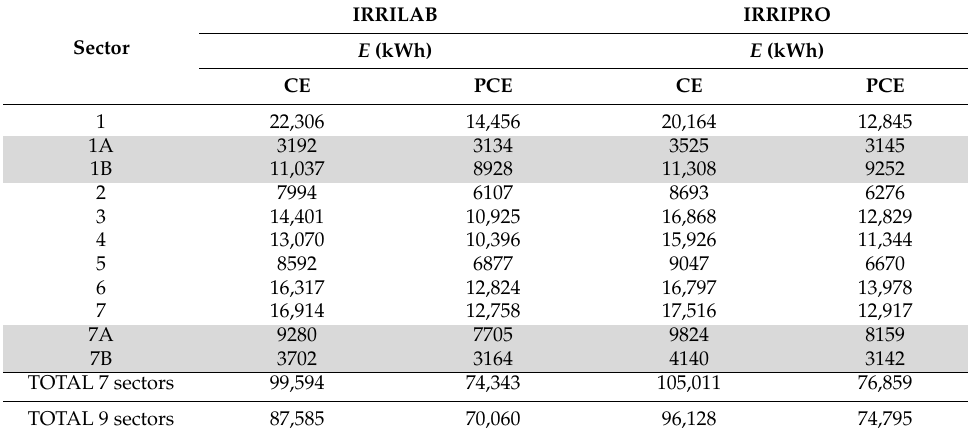
Table 9. Energy, E, required for the micro-irrigation system of the apple farm subdivided in the “almost uniform” seven sectors and nine sectors, by splitting sectors #1 and #7 into two sectors (background gray colored), designed by both IRRILAB and IRRIPRO, for common emitters (CE) and pressure compensating emitters (PCE).